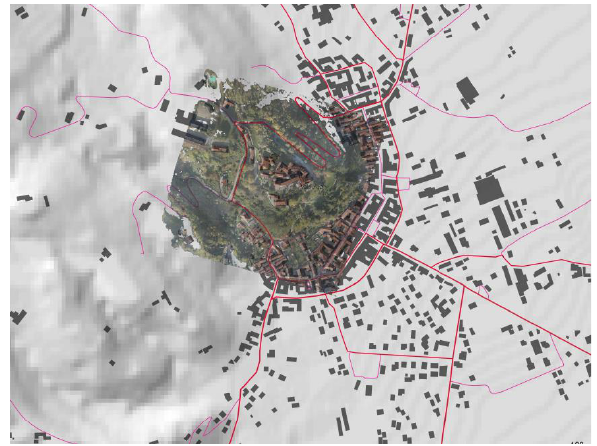
Figure 10. Other two views of an excerpt of the colored cloud; 0.026 m RMSE on GCP shows a good ability to represent the dense edification.